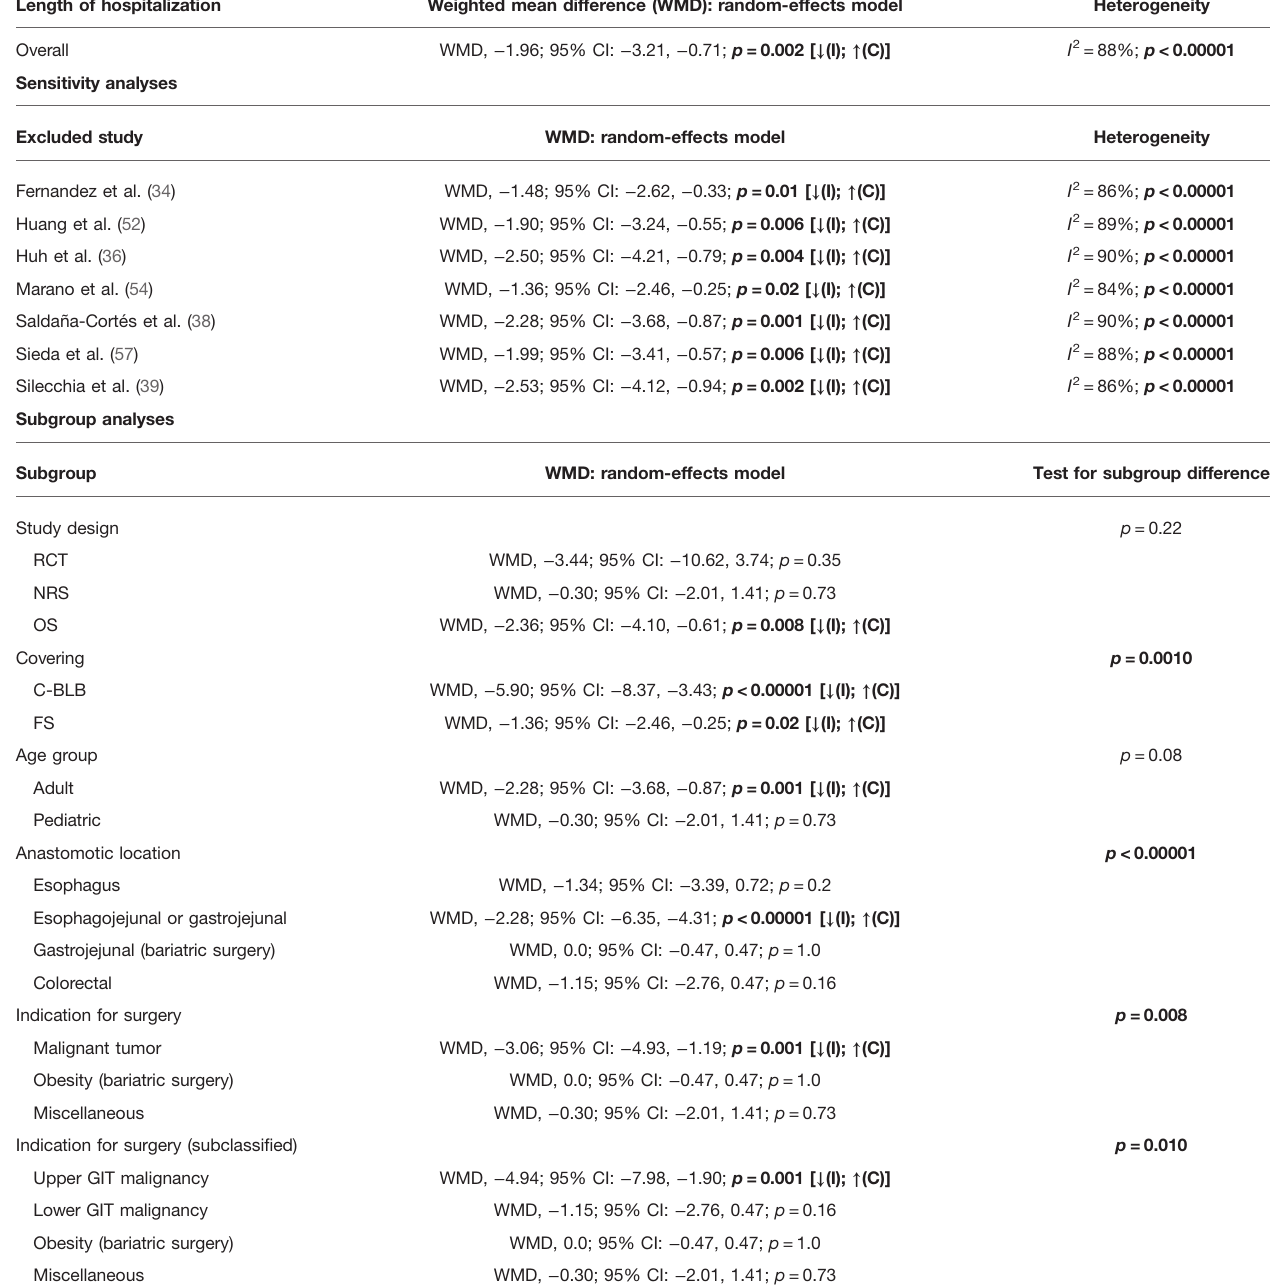
study design (TSD: p = 0.66), age group (TSD: p = 0.78), anastomotic location (TSD: p = 0.59), and indication for surgery (TSD: p = 0.74) ( Table 8 ).